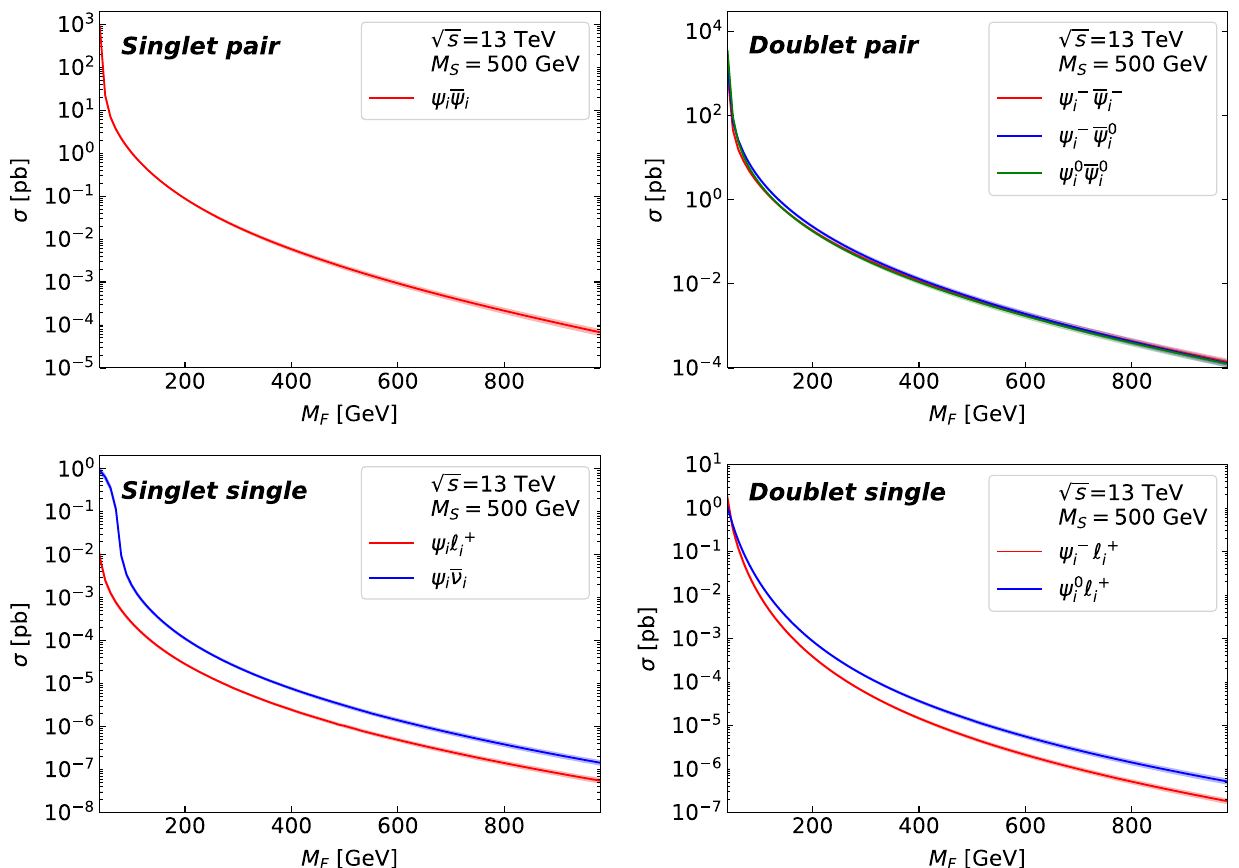
√ s = 13 TeV for different vector-like lepton masses in the